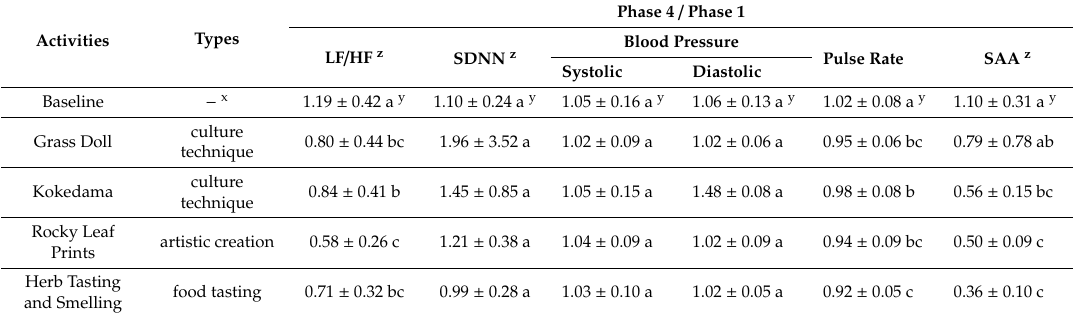
Table 6. E ff ect of various types of horticultural activities on the changes of physiological indices.